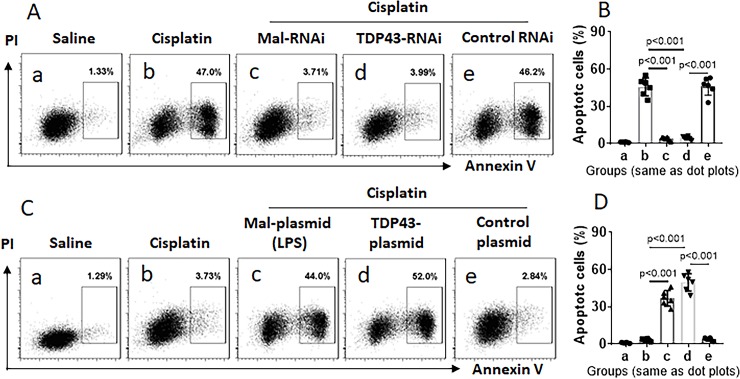
Restoration of apoptotic machinery in LC cells by modulation of Mal or TDP-43 expression.A-B, NC cells were prepared and treated with Mal RNAi or TDP-43 RNAi to knock down the expression of Mal or TDP-43. The cells were exposed to cisplatin in the culture for 48 h. The gated dot plots show apoptotic cells. The bars show summarized data of apoptotic cells. C-D, LC cells were prepared and transfected with Mal-expressing or TDP-43-expressing plasmids as denoted above each subpanel. The cells were exposed to cisplatin in the culture for 48 h. The gated dot plots show apoptotic cells. The bars show summarized data of apoptotic cells. Data of bars are presented as mean ± SEM. Each dot in bars presents data obtained from one sample. The data represent 6 independent experiments. Statistics: ANOVA + Bonferroni test.